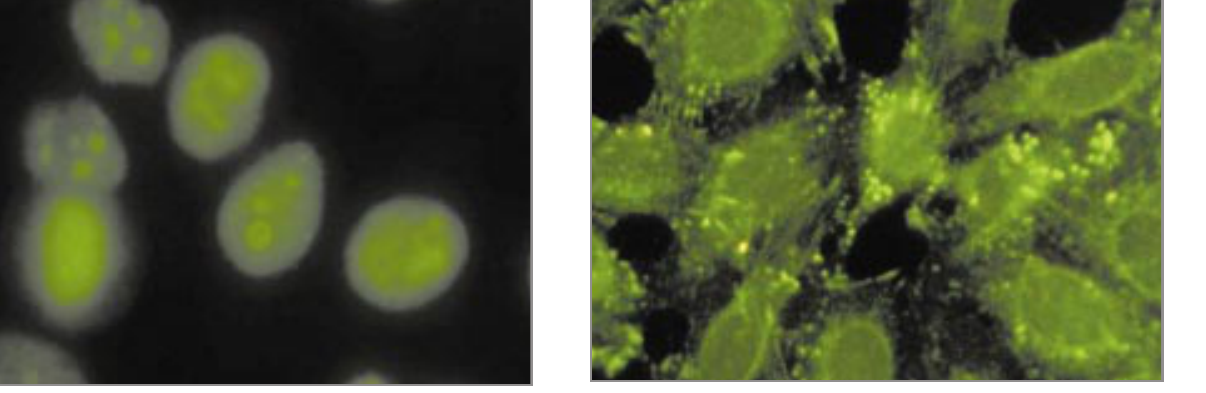
Figura 12 – Nucleolar pontilhado